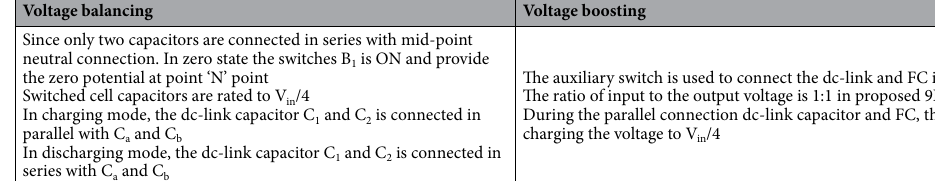
Table 1. Fundamental operation of proposed 9L inverter.